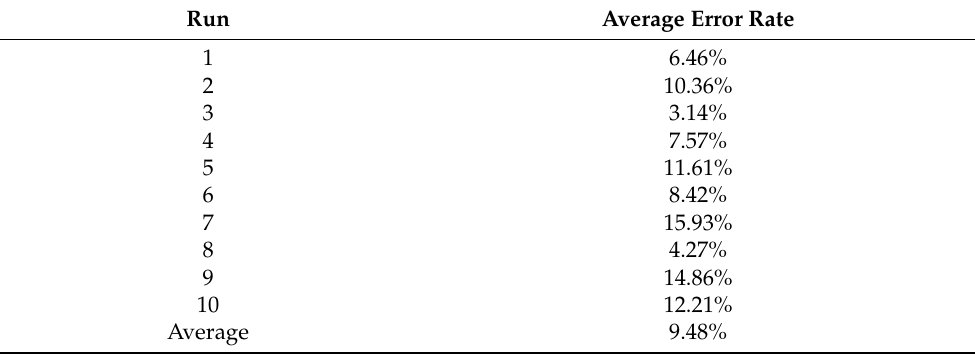
Table 6. The analysis of